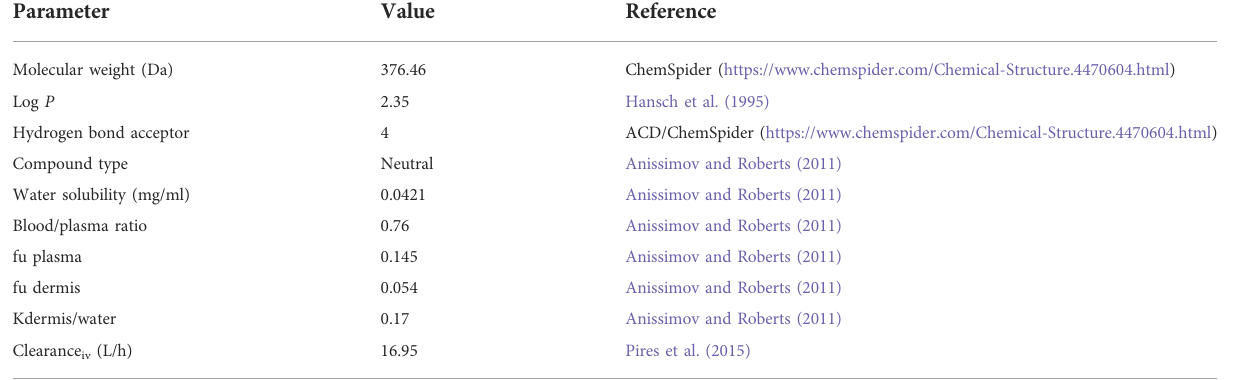
TABLE 1 Physicochemical properties of DSM with reference to relevant